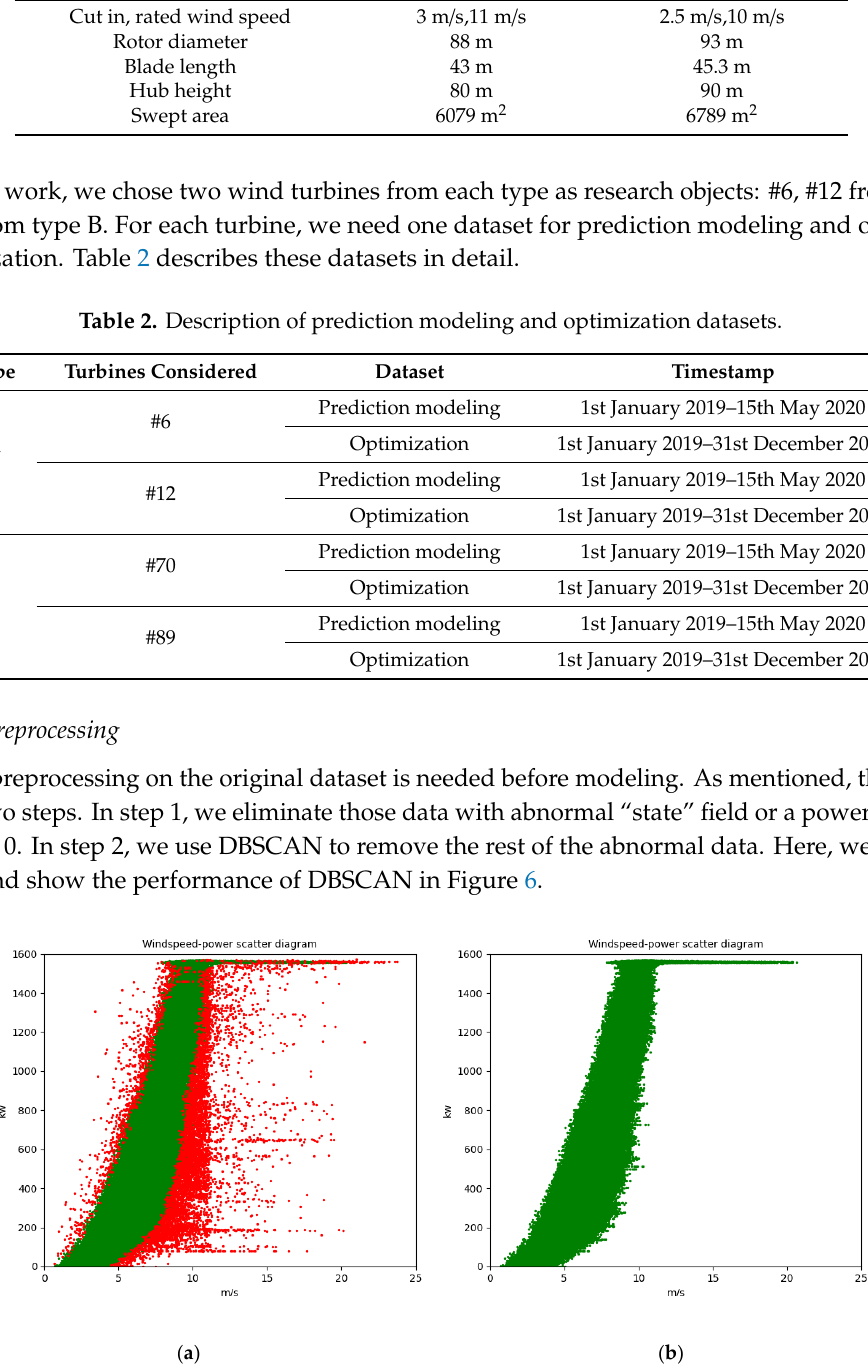
Figure 6. Performance of density-based spatial clustering of applications with noise (DBSCAN): ( a ) result of DBSCAN, ( b ) final dataset.